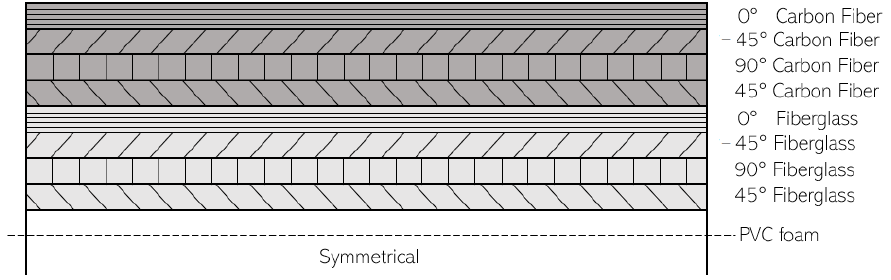
Figure 2. Fixed stack-up sequence on the optimization